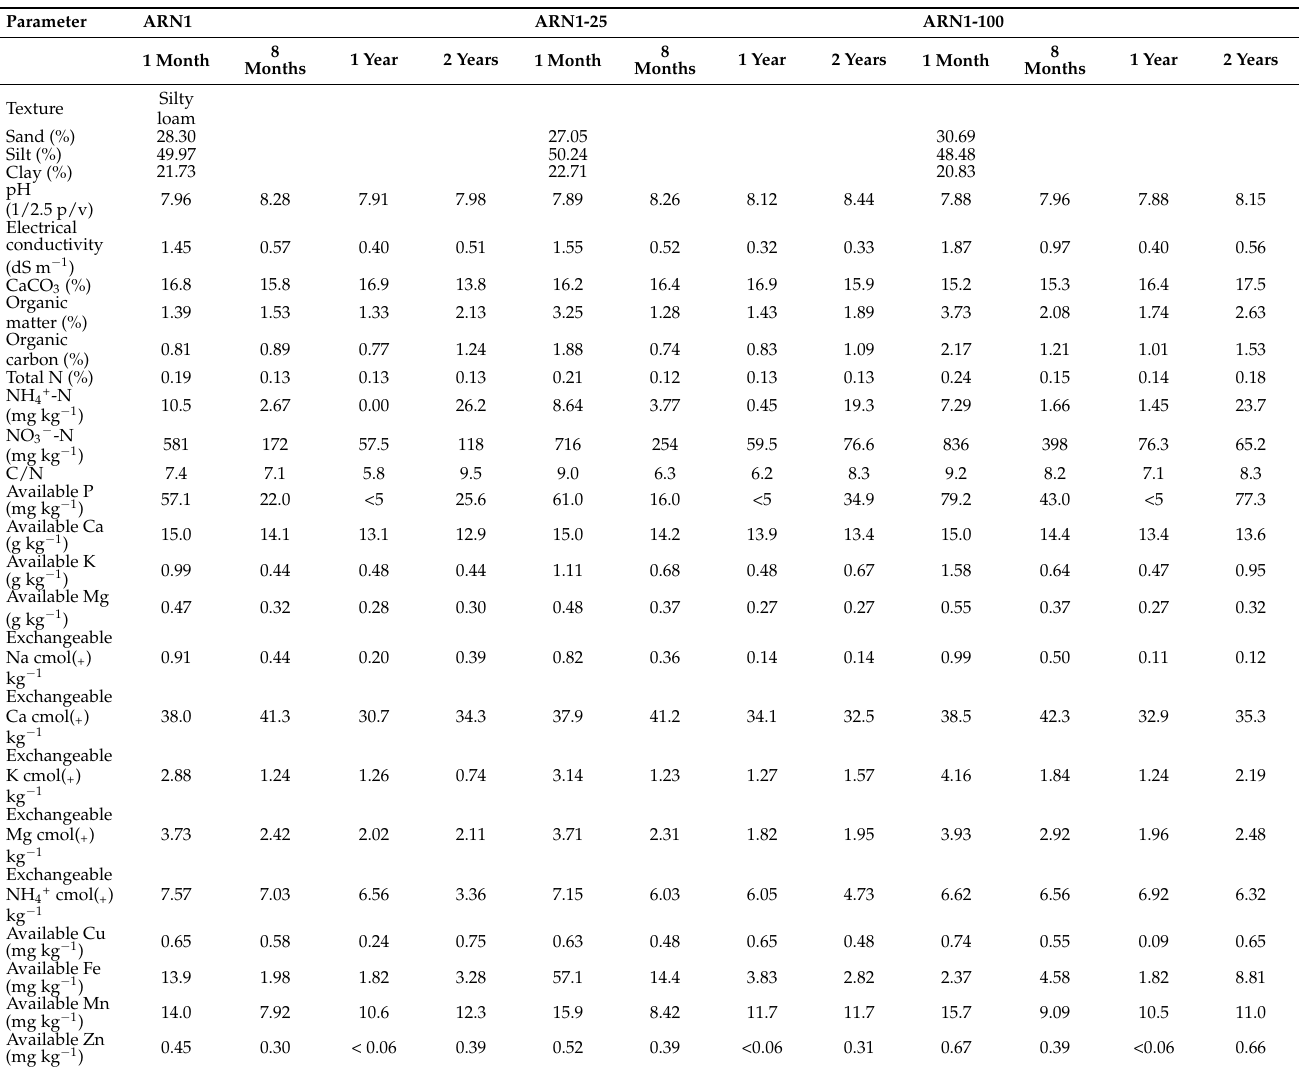
Table 2. Characteristics of unamended soil (ARN1) and of soil amended with SMS at two doses (ARN1-25 and ARN1-100) over the experimental